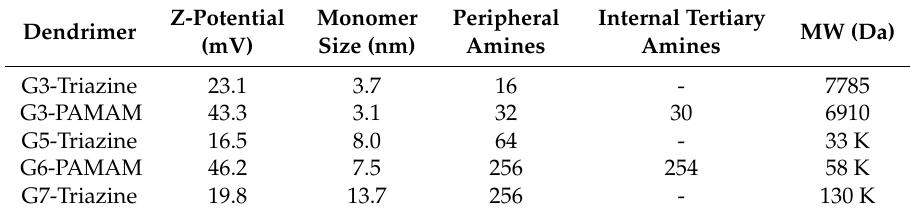
Table 1. Comparison of triazine and PAMAM dendrimers.